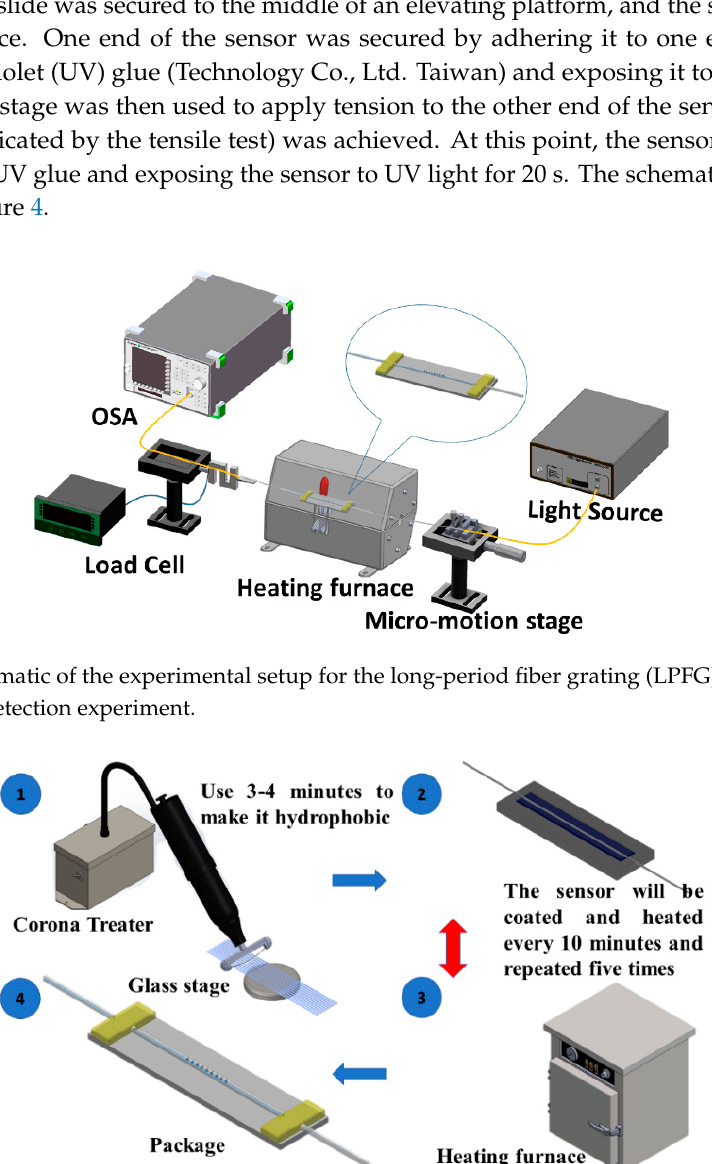
Figure 3. Schematic of the experimental setup for the long-period fiber grating (LPFG) sensor in the temperature detection experiment.